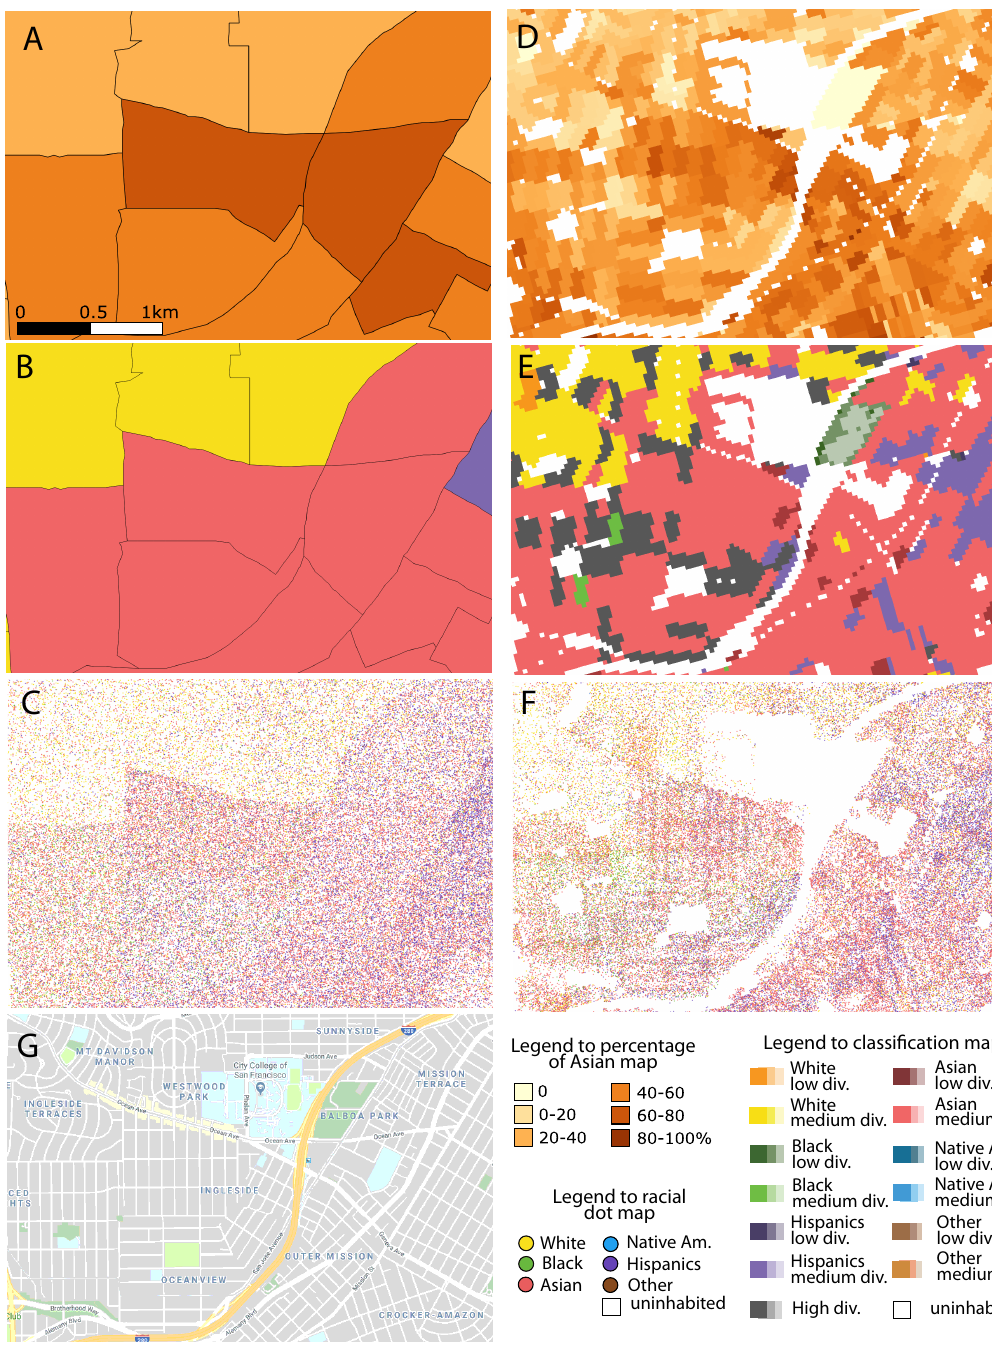
Figure 1. Comparison of different maps visualizing racial segregation/diversity in the Balboa Park site in San Francisco. Maps on the left, ( A – C ), are based on Census tracts data, and maps on the right ( D – F ) are based on gridded data. The top row shows maps depicting the percentage of the Asian population; the second row shows maps depicting diversity/top race classification; and the third row shows racial dot maps. ( G ) is the Google Street Map of the site. Color shades in the legend for diversity classification maps reflect overall population